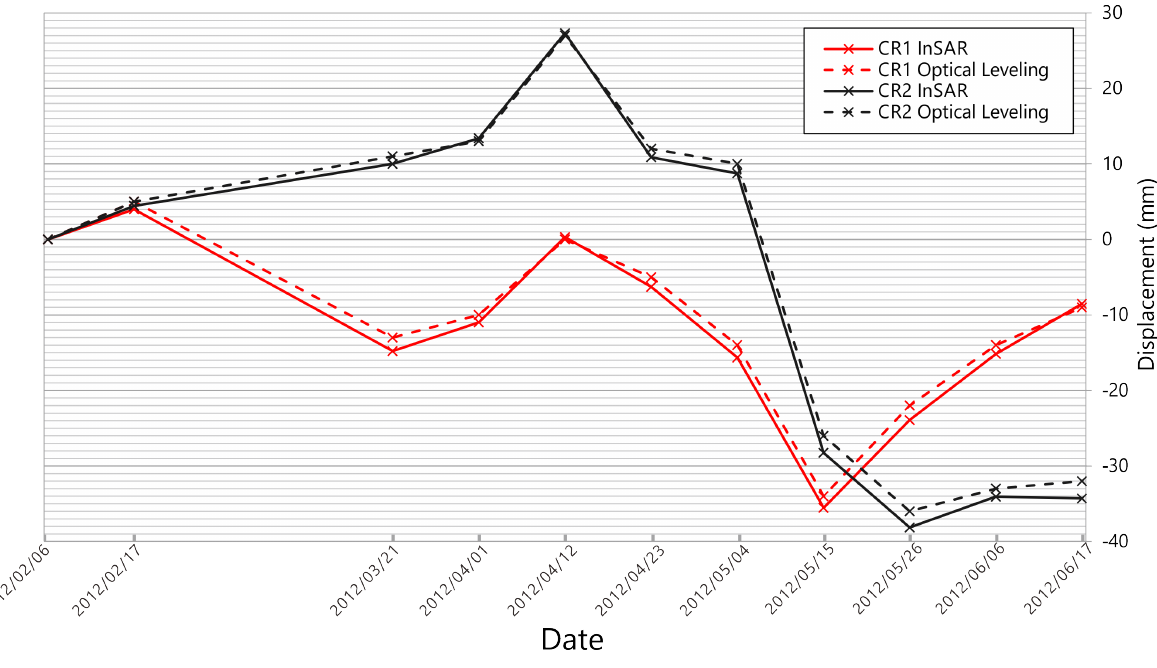
Figure 14. The relative vertical displacements time series compared to CR3 retrieved by InSAR in comparison to the result retrieved by the leveling survey.